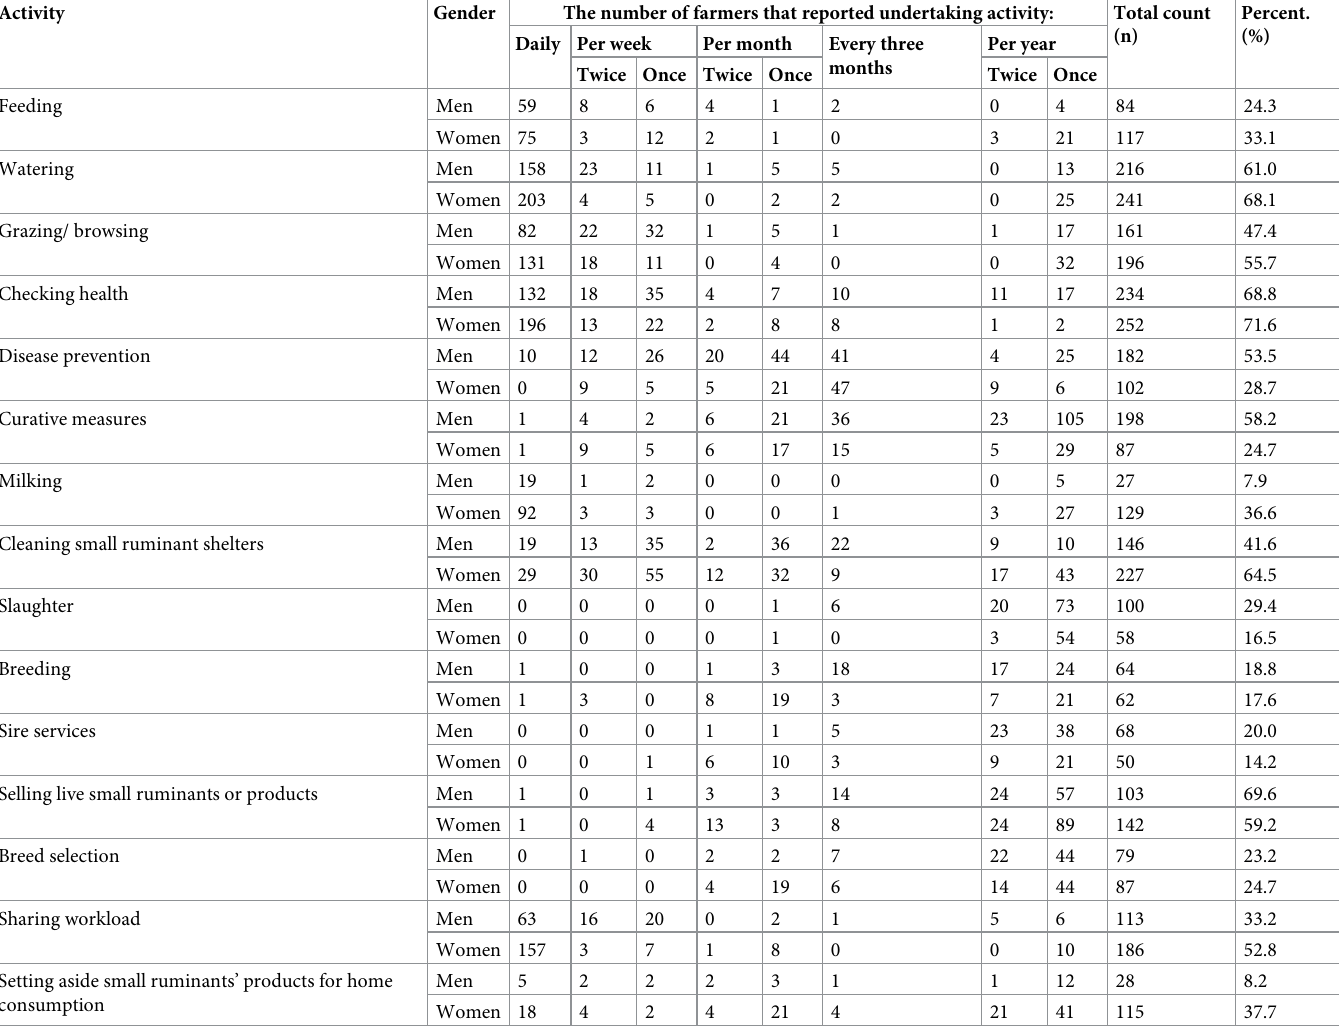
Table 5. Participation of men and women in different small ruminant production activities. Activity